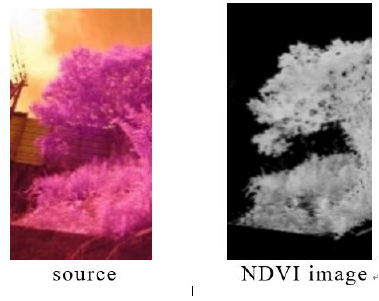
Figure 7. Image after projective transformation